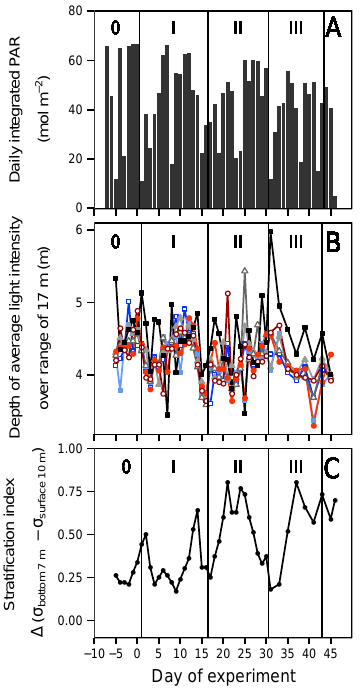
Figure 6. (a) Daily integrated incoming photosynthetically active radiation (PAR) measured by a unobstructed sensor on land during the study period, (b) depth of average water column light intensity calculated from CTD PAR sensor profiles between 0 and 17m deep, and (c) stratification index calculated from σ T difference between the top 10m and bottom 7m in M8 as representative of all meso- cosms. Symbols and colours are described in Table 1.